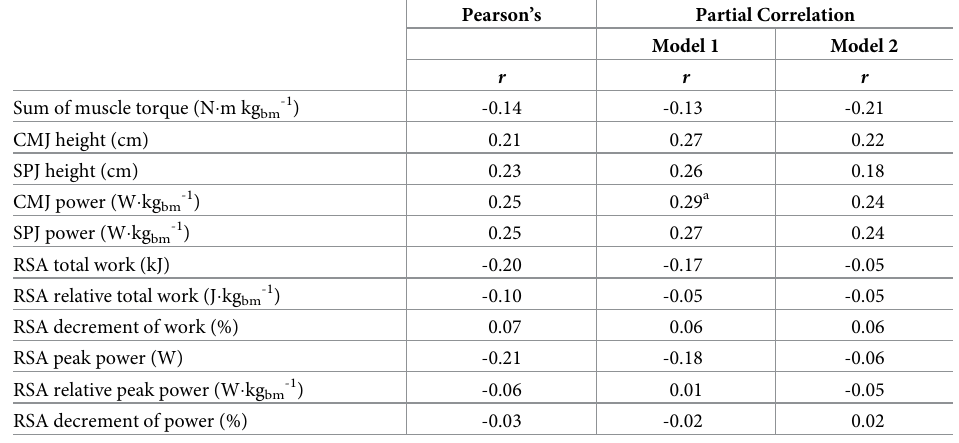
Table 2. Pearson’s and partial correlations between exercise performance and (log of) 25(OH)D concentration (n = 50).